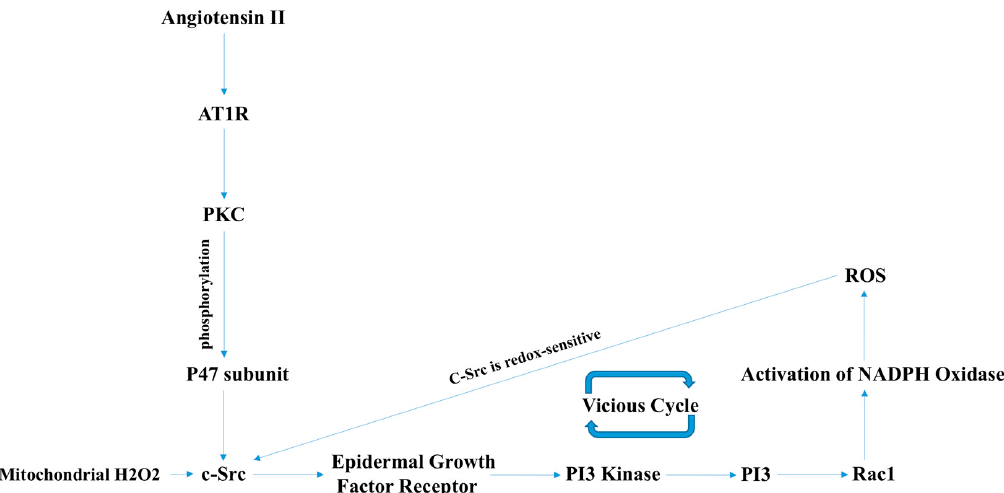
Figure 4. AngII induces NADPH oxidase-derived ROS and mitochondrial ROS, which, in turn, activate c-Src-PI3K-Rac1-induced NADPH oxidase, resulting in a positive feedforward “vicious cycle” of oxidative stress. H 2 O 2 activates the c-Src enzyme, which, in turn, activates the Rac1-dependent NADPH oxidase enzyme and produces O 2 − . Activated c-Src induces the PI3K-Akt signaling cascade, which, in turn, activates Rac1 and, thus, NADPH oxidase, resulting in further ROS production. PKC: Protein Kinase-C.